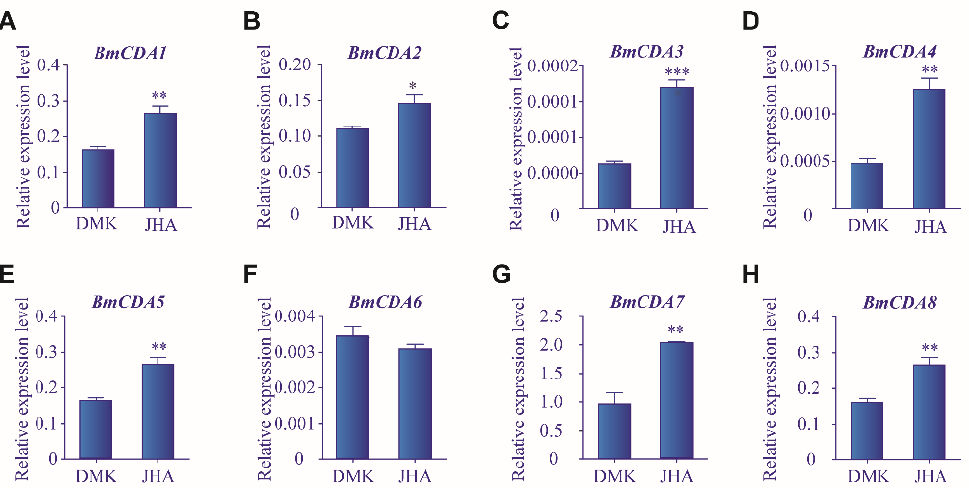
Figure 6. The influence of juvenile hormone analog (JHA) on the expression of eight Bombyx mori chitin deacetylases ( BmCDAs ). The mRNA expression levels of BmCDAs were detected using RT-qPCR 24 h after injection of JHA. Dimethyl ketone (DMK) was used in the control group. * p < 0.05, ** p < 0.01, *** p < 0.001 vs. control.